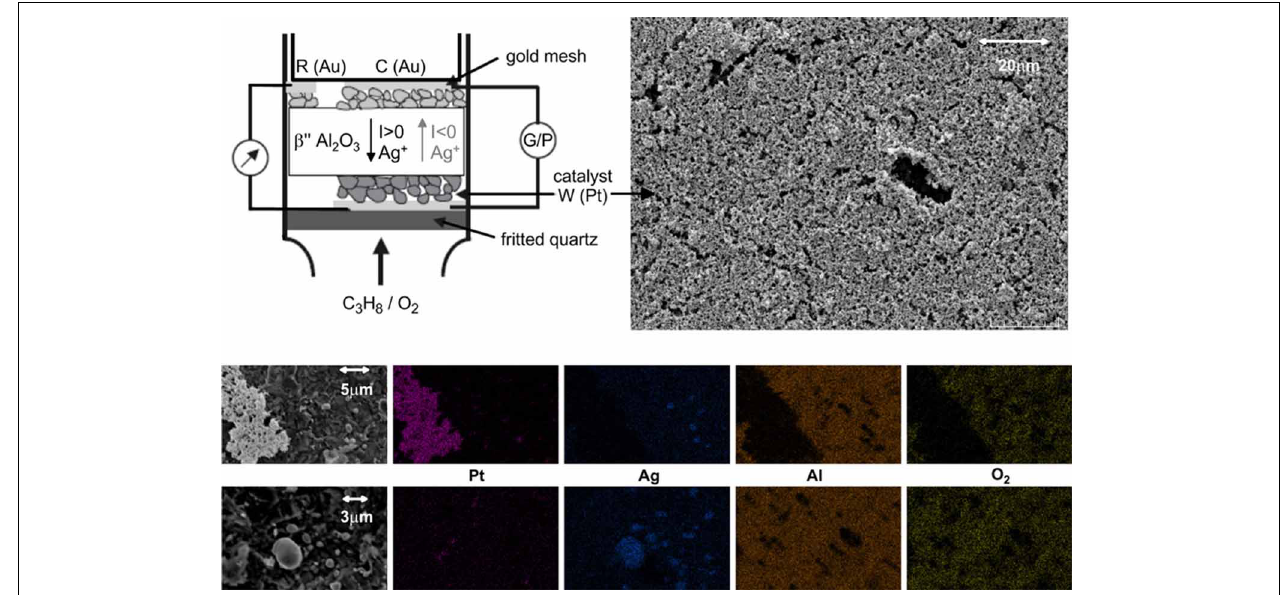
FIGURE 1 | Schematic drawing of the electrochemical catalyst Pt/ β (cid:2)(cid:2) -Al 2 O 3 (Ag + ) placed in the quartz reactor (the galvanostat/potentiostat is denoted as G/P) and SEM micrograph